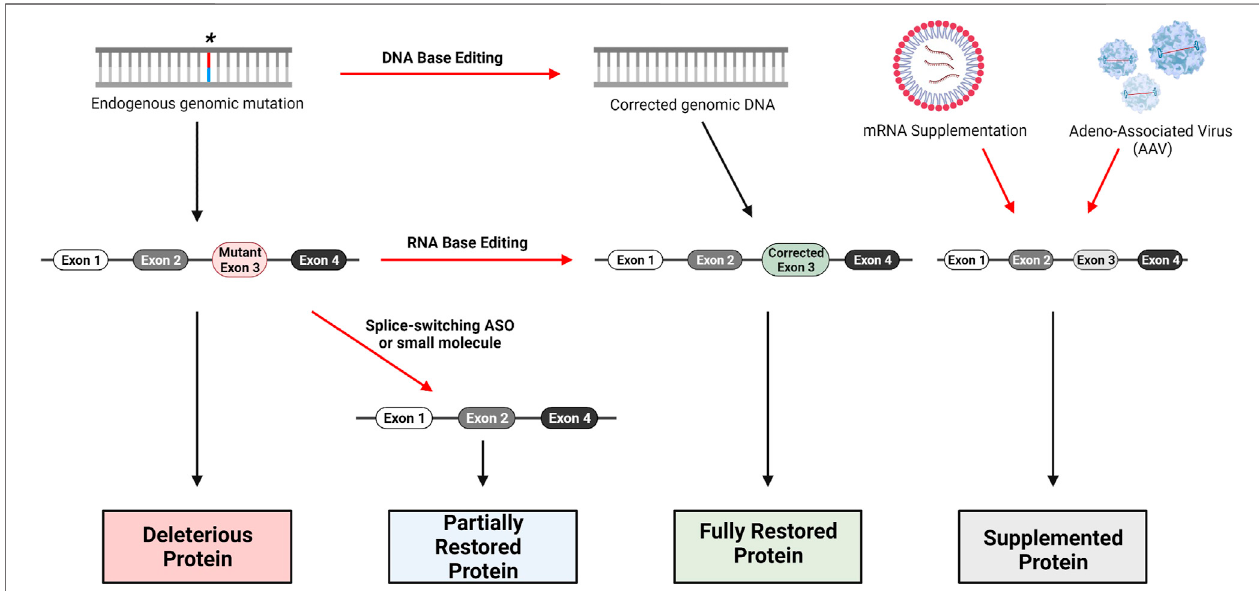
FIGURE 3 | Gene therapy approaches for loss-of-function genetic disorders. DNA base editing technologies include CRISPR/Cas9, Zinc-Finger Nucleases (ZFN) and Transcription Activator-Like Effector Nucleases (TALENS). RNA base editing of pre-mRNA can be performed with the CasRx system, utilizing Cas13. Skipping of mutant-containingexonsduringmRNAprocessingcanbeperformedwithAntisenseOligonucleotides(ASO)speci fi callydesignedtobindrelevantintron-exonjunctions; small-molecules such as risdiplam are also capable of altering splicing. Traditional replacement therapy including mRNA supplementation and AAV delivery are possible as well, though several factors complicate this approach for Alagille Syndrome as we have discussed.